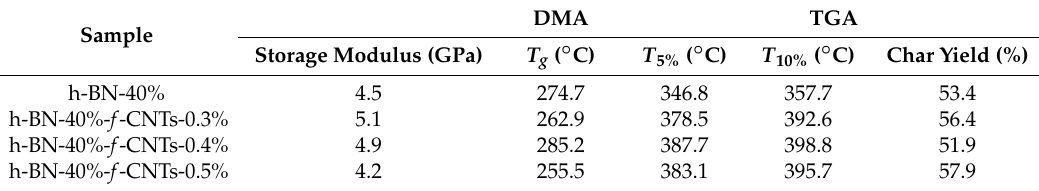
Table 3. Thermal properties of h-BN/ f -CNTs reinforced composites.